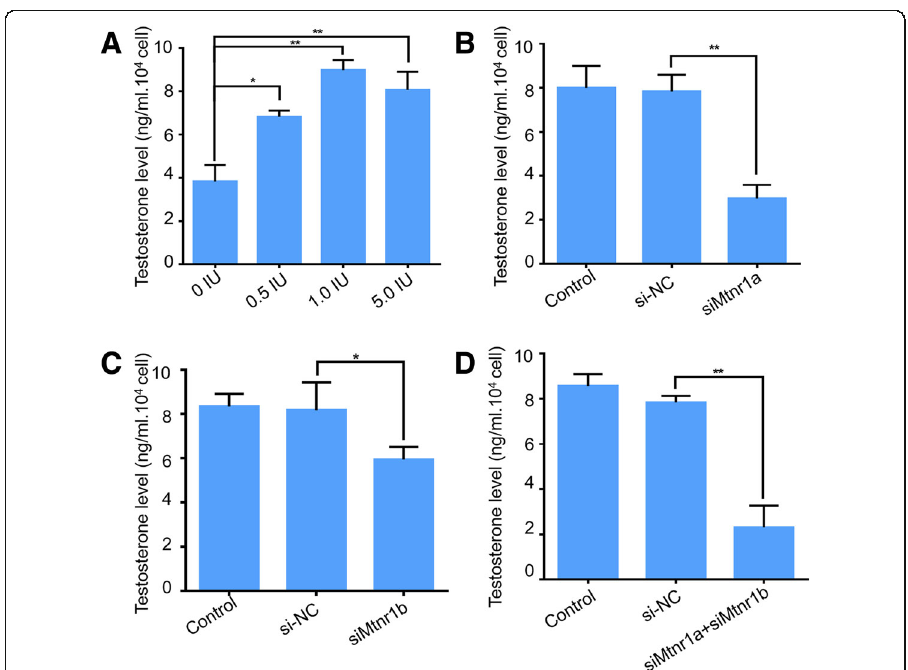
Fig. 3 Effect of MTNR1A and MTNR1B knockdown on testosterone secretion in mLTC-1. a . mLTC-1 cells were treated with 0, 0.5, 1.0 and 5.0 IU/ml of hCG for 6 h before detection of testosterone level using ELISA. The results indicate that 1 IU/ml is the optimal dose for testosterone synthesis. b and c . ELISA results of testosterone secretion after interference of MTNR1A or MTNR1B using siRNA in mLTC-1. d . ELISA result of testosterone secretion after interference with both MTNR1A and MTNR1B in mLTC-1. Data are presented as mean ± SEM of triplicate experiments. * P < 0.05, ** P < 0.01 (Student ’ s